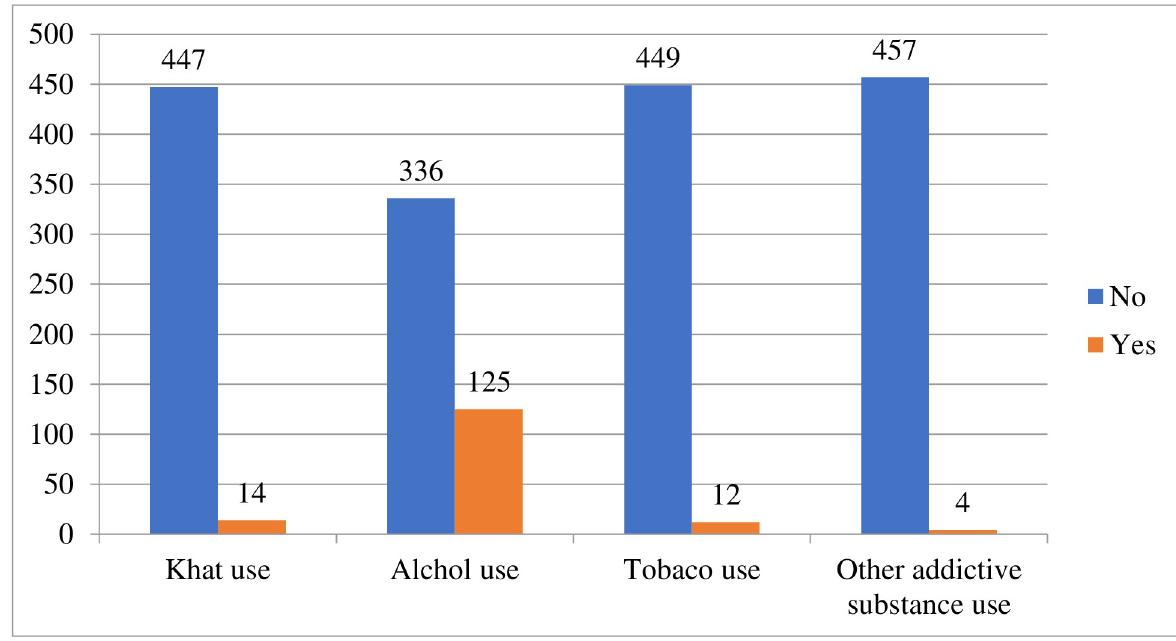
Fig 4. Substance use among DMU school SMCHS students on mental distress, North West, Ethiopia, 2021 (N = 461).